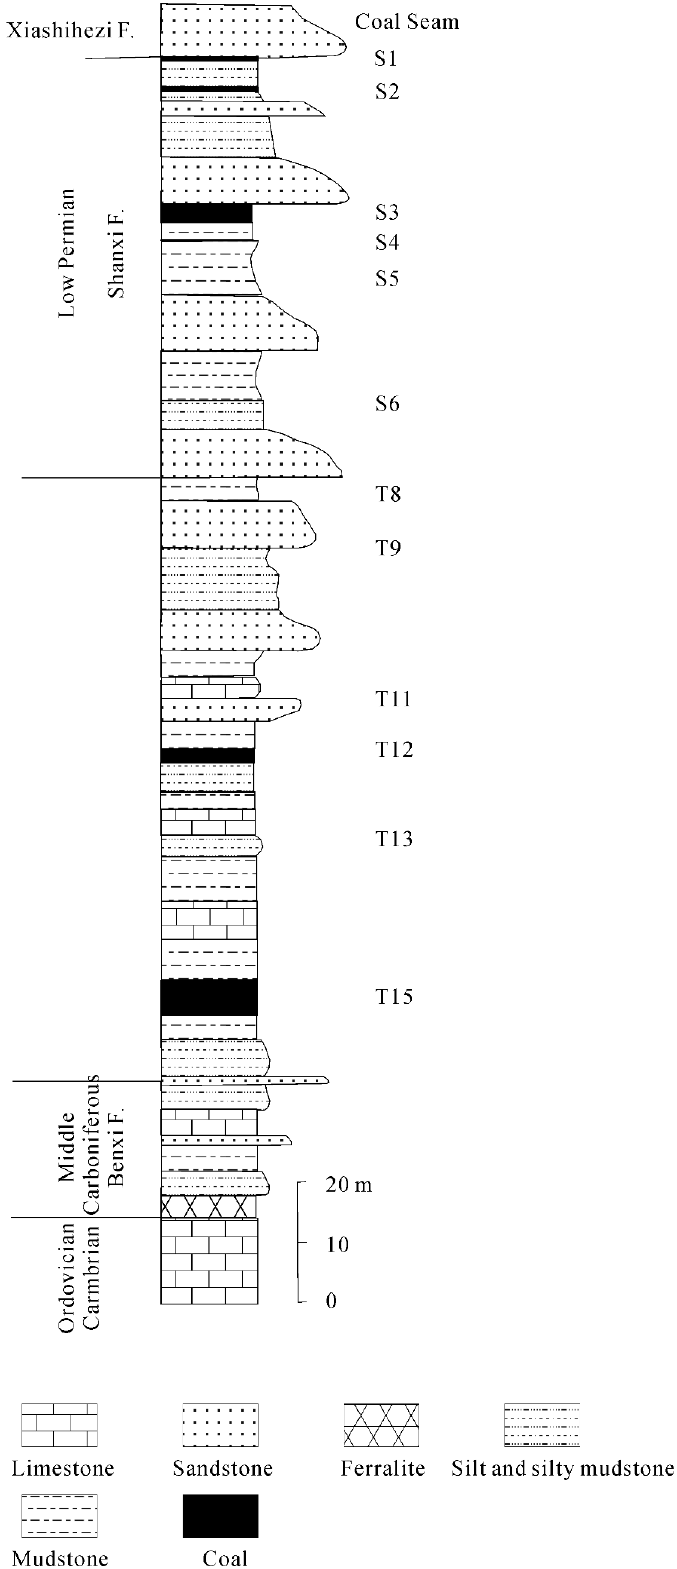
Figure 1. Stratigraphic series of the Carboniferous and Permian coal-bearing strata from Yangquan, Shanxi, China (Reproduced with permission from [Jiao & Wang], [Depositional environments of the coal-bearing strata and their controls on coal seams in the Yangquan mining district, Shanxi]; published by [Sedimentary Facies and Palaeogeography], 1999) [44].